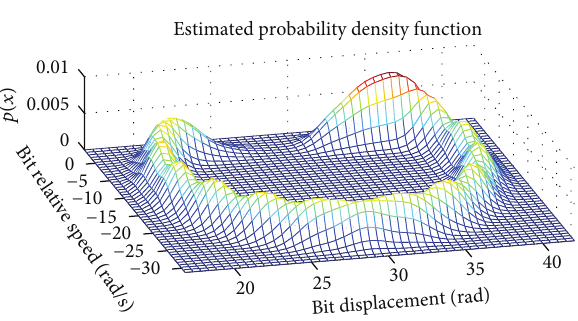
Figure 8: Probability density evolution in stick-slip.